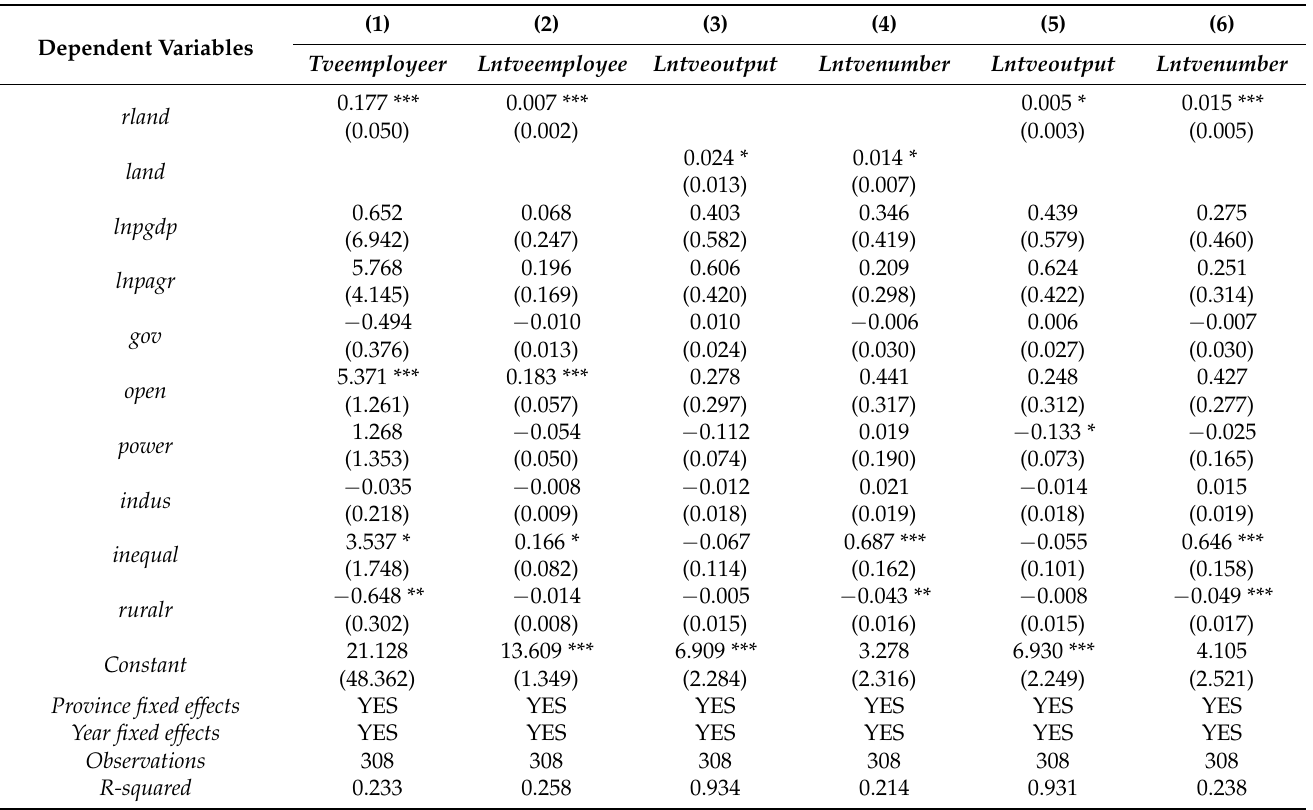
Table 3. Robustness tests: replace explanatory and explained